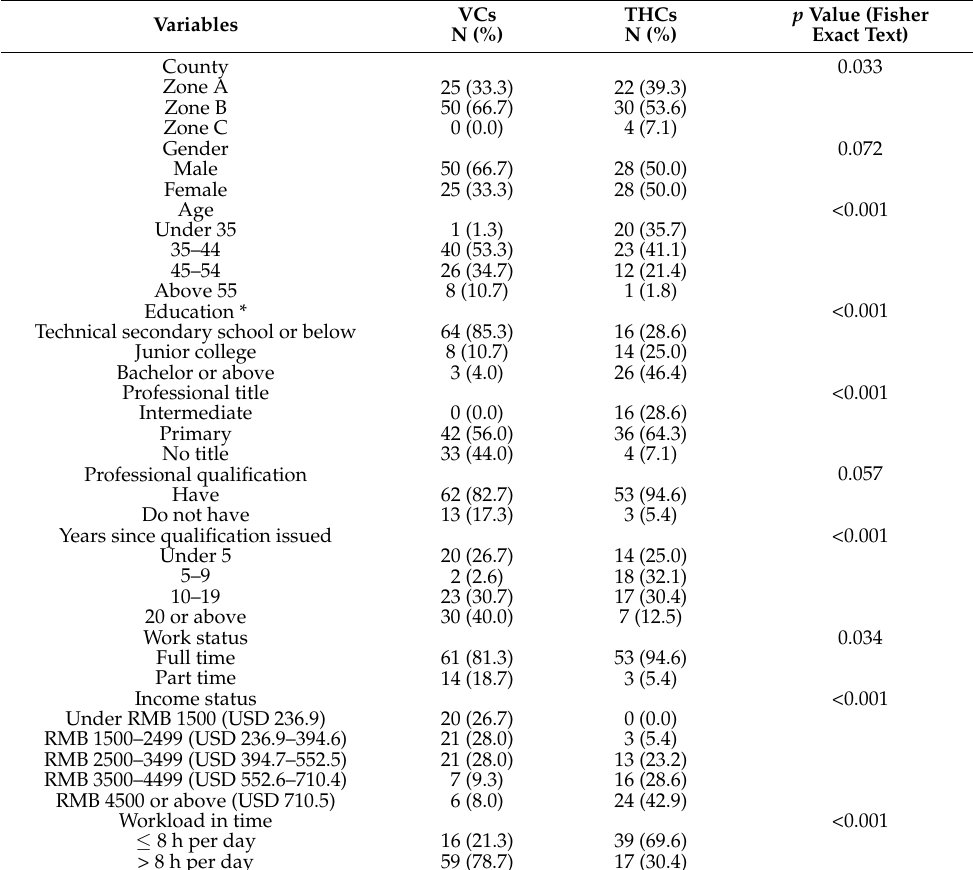
Table 2. Univariate analyses grouped by township health centers and village